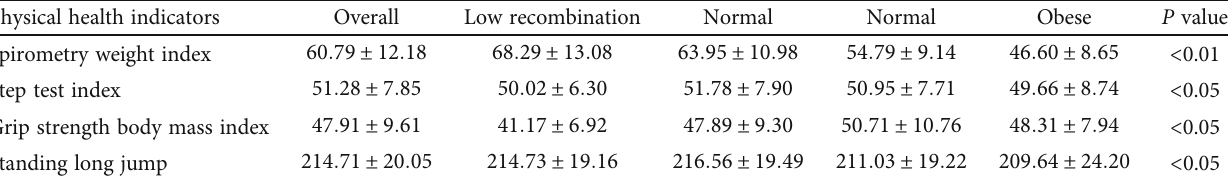
Table 1: Statistics of physical health indicators for male students and signi fi cance test of BMI with each physical health indicator. Physical health indicators